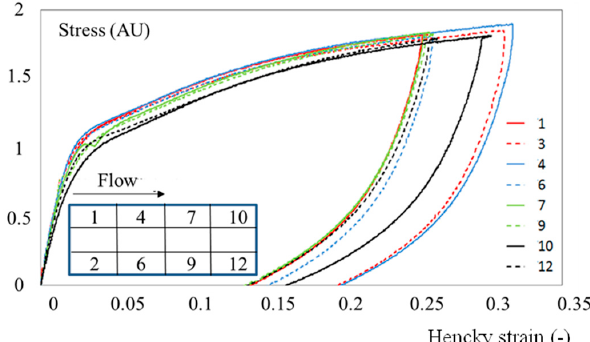
Figure 4. Loading-unloading stress vs. strain cycles under tension at 23 °C. The water content is 2 wt.%. The strain rate is 4 10 − 3 s − 1 . Figures in the legend refer to the location in the plaque as depicted in the schematic on the left.